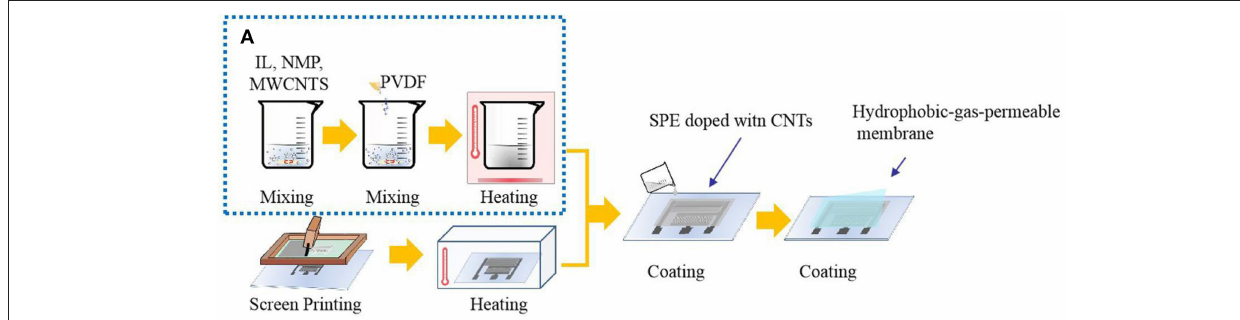
FIGURE 2 | The measurement setup: (A) the structure of the prepared gas sensor [the numbers in the figure are marked as follows: (1) working electrode, (2) reference electrode, (3) auxiliary electrode, (4) solid polymer electrolyte (SPE), (5) PET film substrate, and (6) the hydrophobic-gas-permeable membrane].